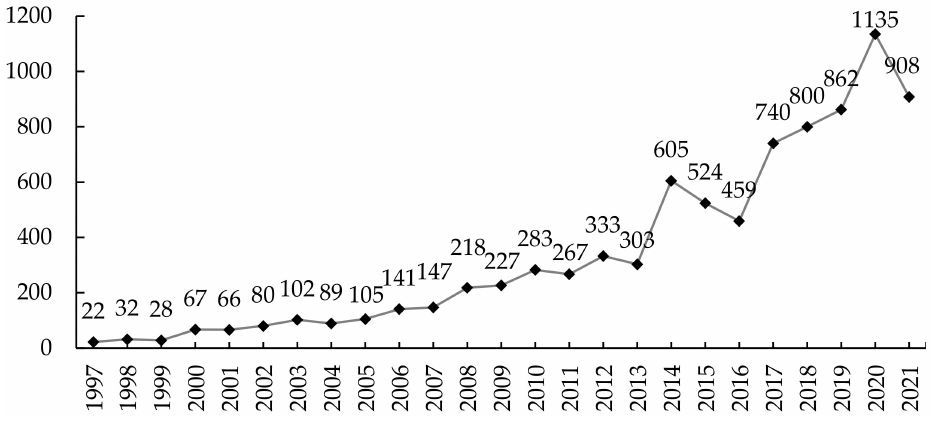
Figure 1. Articles published over the